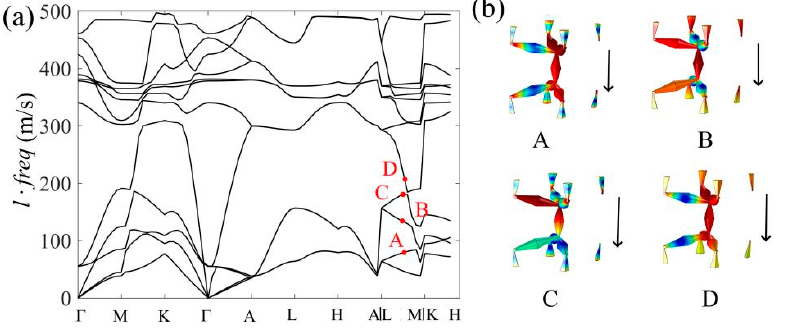
Figure 8. The band structures ( a ) and specific modes ( b ) of the varied cell with η h = 0.3.